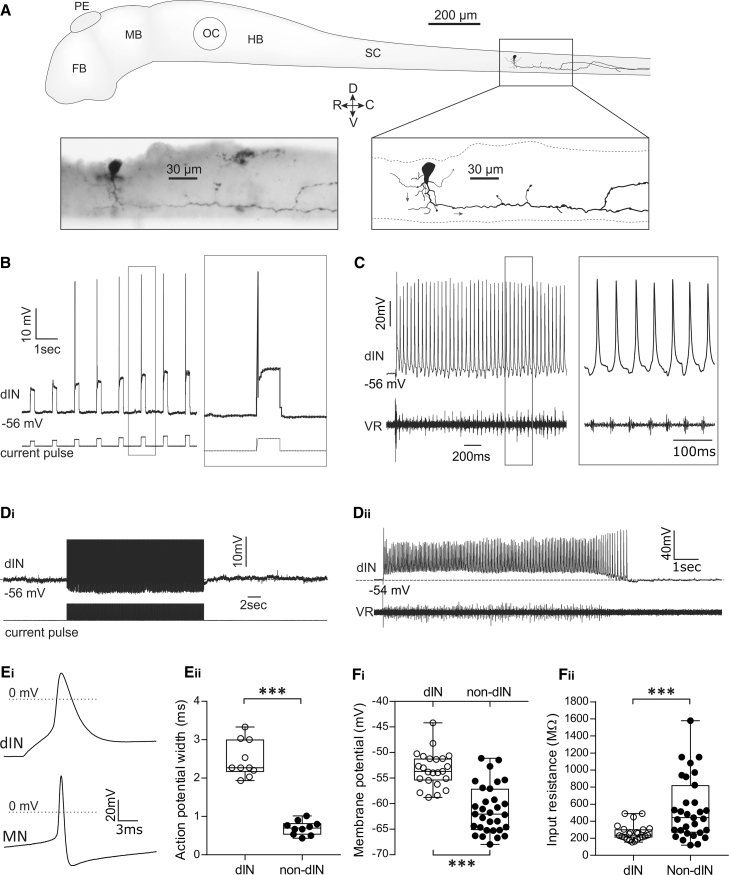
Properties of dINs in Stage 42 Larval Xenopus Tadpoles(A) The anatomy of a dIN. The axon courses ventrally and then caudally. Arrows on the image indicate the direction of the axon. FB, forebrain; HB, hindbrain; MB, midbrain; OC, otic capsule; PE, pineal eye; SC, spinal cord.(B) Responses of a dIN to depolarizing current pulses of increasing amplitude. Unlike non-dINs, suprathreshold pulses at all amplitudes generate only a single spike.(C) During swimming, dINs also only fire a single spike per swim cycle. VR, ventral root.(D) Unlike all other neuron types in the Xenopus spinal motor circuit, dINs never display a usAHP in response to a protocol inducing repetitive spiking (Di) or after swimming (Dii). Note that action potentials in (Di) have been truncated.(E) The action potential shape of larval dINs is different from non-dINs. Examples of a dIN and motoneuron (MN) action potential in response to a suprathreshold depolarizing pulse (Ei) are shown. Pooled action potential width of dINs and non-dINs measured at 0 mV (Eii; n = 10; ∗∗∗p < 0.001; median with 50% interquartile range (IQR) displayed as box-and-whisker plots).(F) The intrinsic properties of dINs (n = 28) differ from non-dINs (n = 31) and display a significantly more depolarized RMP (Fi) and significantly lower input resistance (Fii; median with 50% IQR displayed as box-and-whisker plots). ∗∗∗p < 0.001. See also Figure S1.